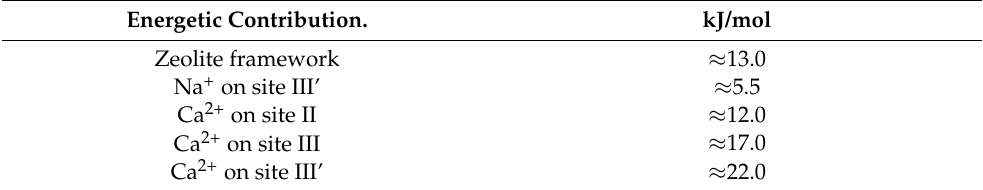
Table 2. Estimated energetic contributions of the cation sites and the zeolite framework in methane adsorption on zeolite type X at 298.15